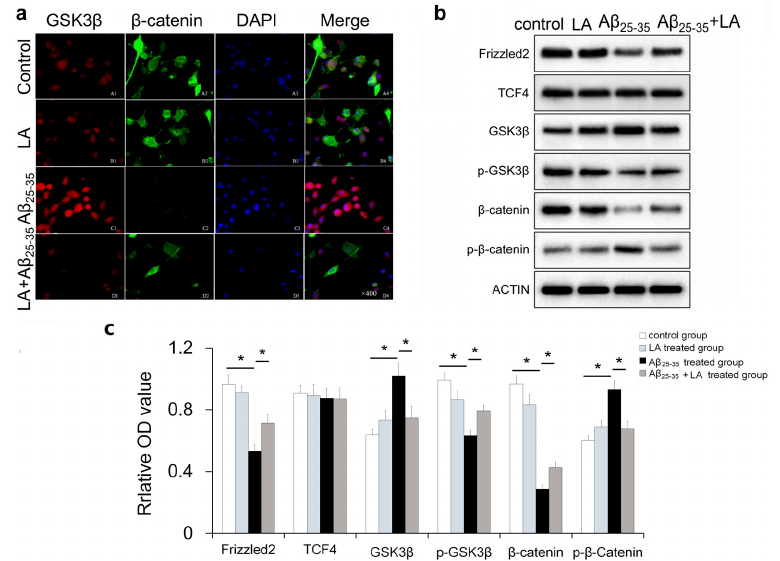
Figure 7. 100 μ mol/L α -lipoic acid (LA) rescued the inactivated Wnt pathway induced by 25 μ mol/L A β 25–35 in BV2 cells. ( a ) The expression and localization of GSK3 β (red) and β -catenin (green) were visualized by confocal analysis (100×). ( b ) Western blot was performed to analyze the expression of Frizzled2, TCF4, GSK3 β , p-GSK3 β , β -catenin, and p- β -Catenin. ( c ) Statistical results of the protein expression in Western blot from b. The data are presented as the mean ± SD of three independently performed experiments. * p < 0.05.